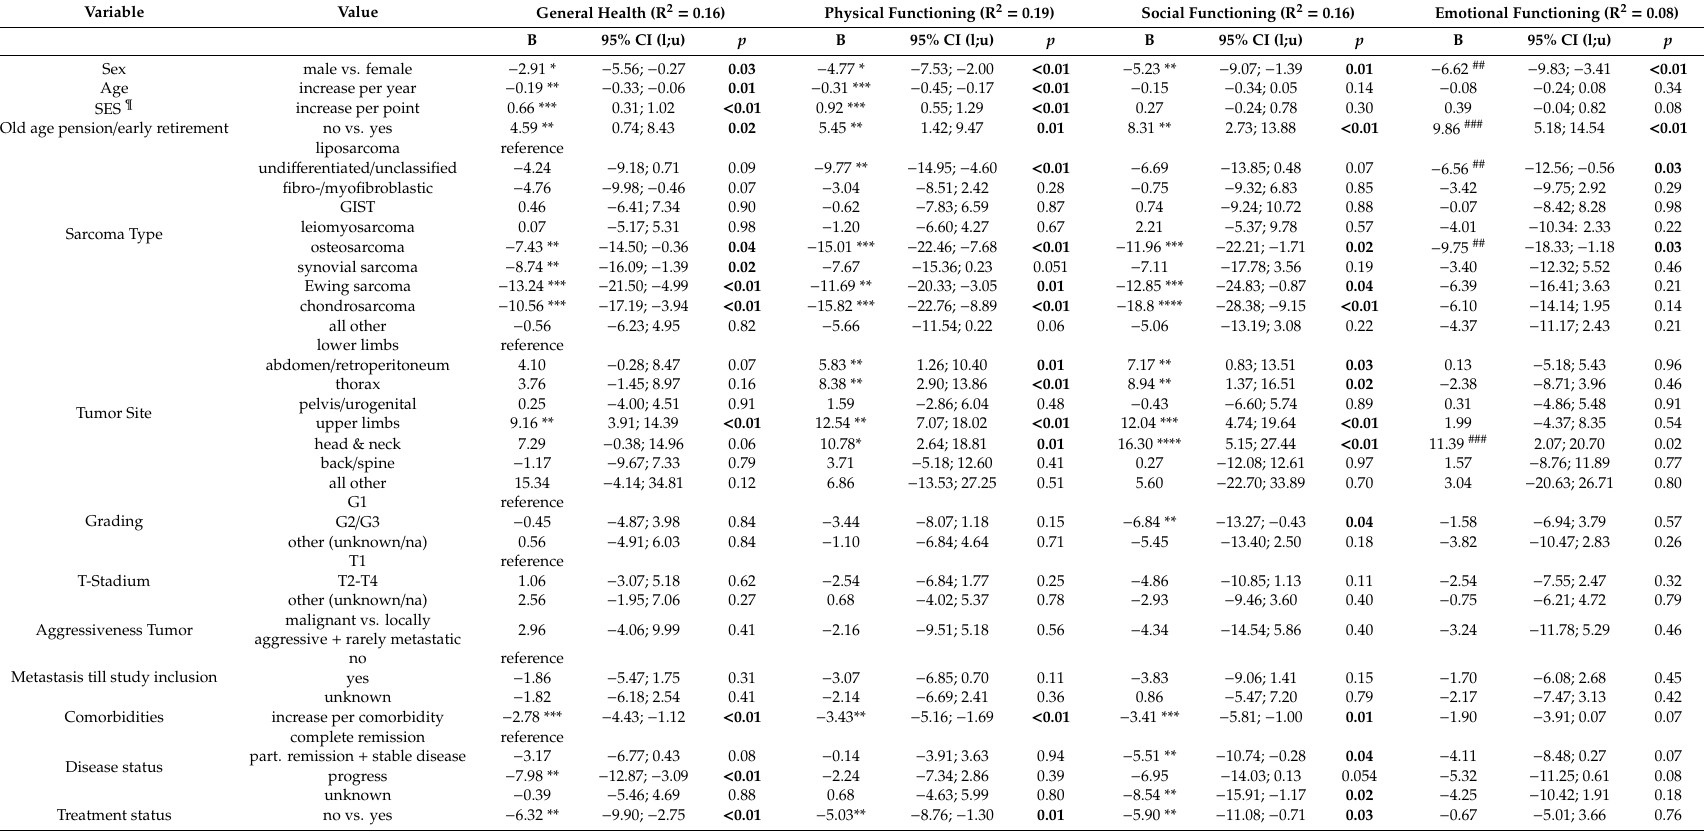
Table 3. Results of the multivariable linear regression. # no di ff erence; ## small di ff erence; ### moderate di ff erence (Osoba 1998). * trivial di ff erence; ** small di ff erence; *** medium di ff erence; **** large di ff erence (Cocks 2011); ¶ 35 values imputed. For continuous variables we compared: Age: 50-year di ff erence. SES: 18-point di ff erence; Comorbidities: 4-point di ff erence. Significant Di ff erences: bold. R 2 = coe ffi cient of determination; B = non-standardized regression coe ffi cient (indicating a B point increase or decrease in the respective QoL scale); 95% CI (lower;upper): 95% confidence interval; p = p -value; na: not applicable; RT: radio therapy; CT: chemo therapy; SES: socioeconomic